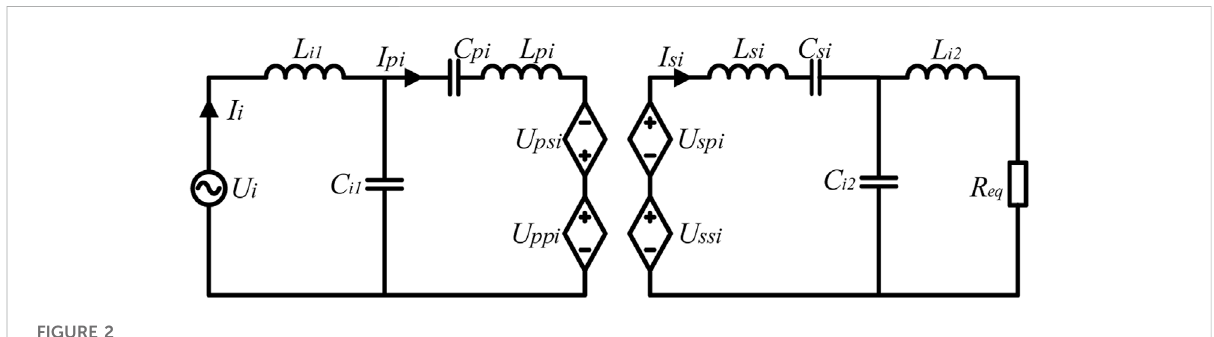
FIGURE 2 Equivalent circuit of the MTMR WPT